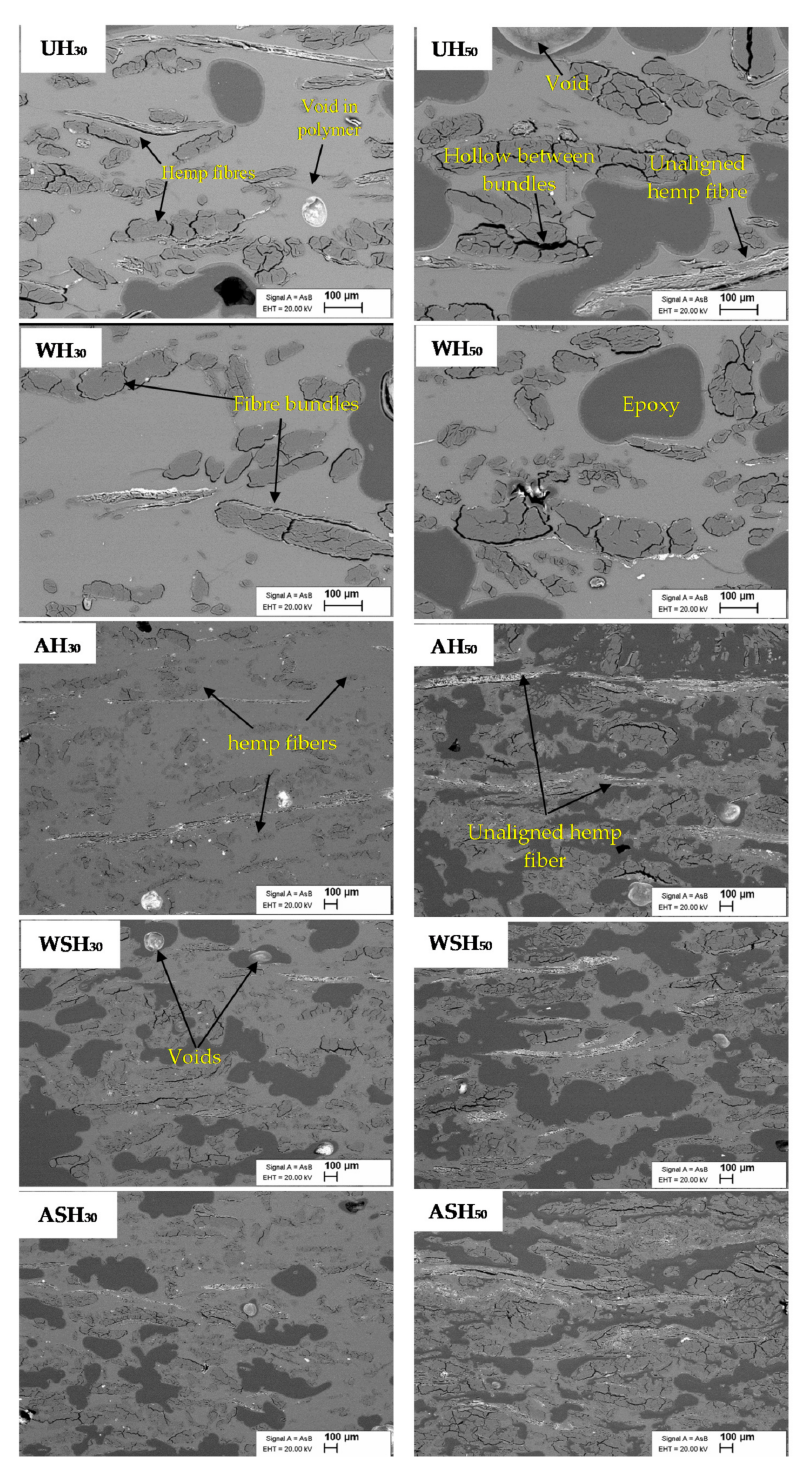
Figure 5. The cross-sectional images of reinforced PLA composites (UH, WH, AH, WSH and ASH) at 30 and 50% hemp fiber